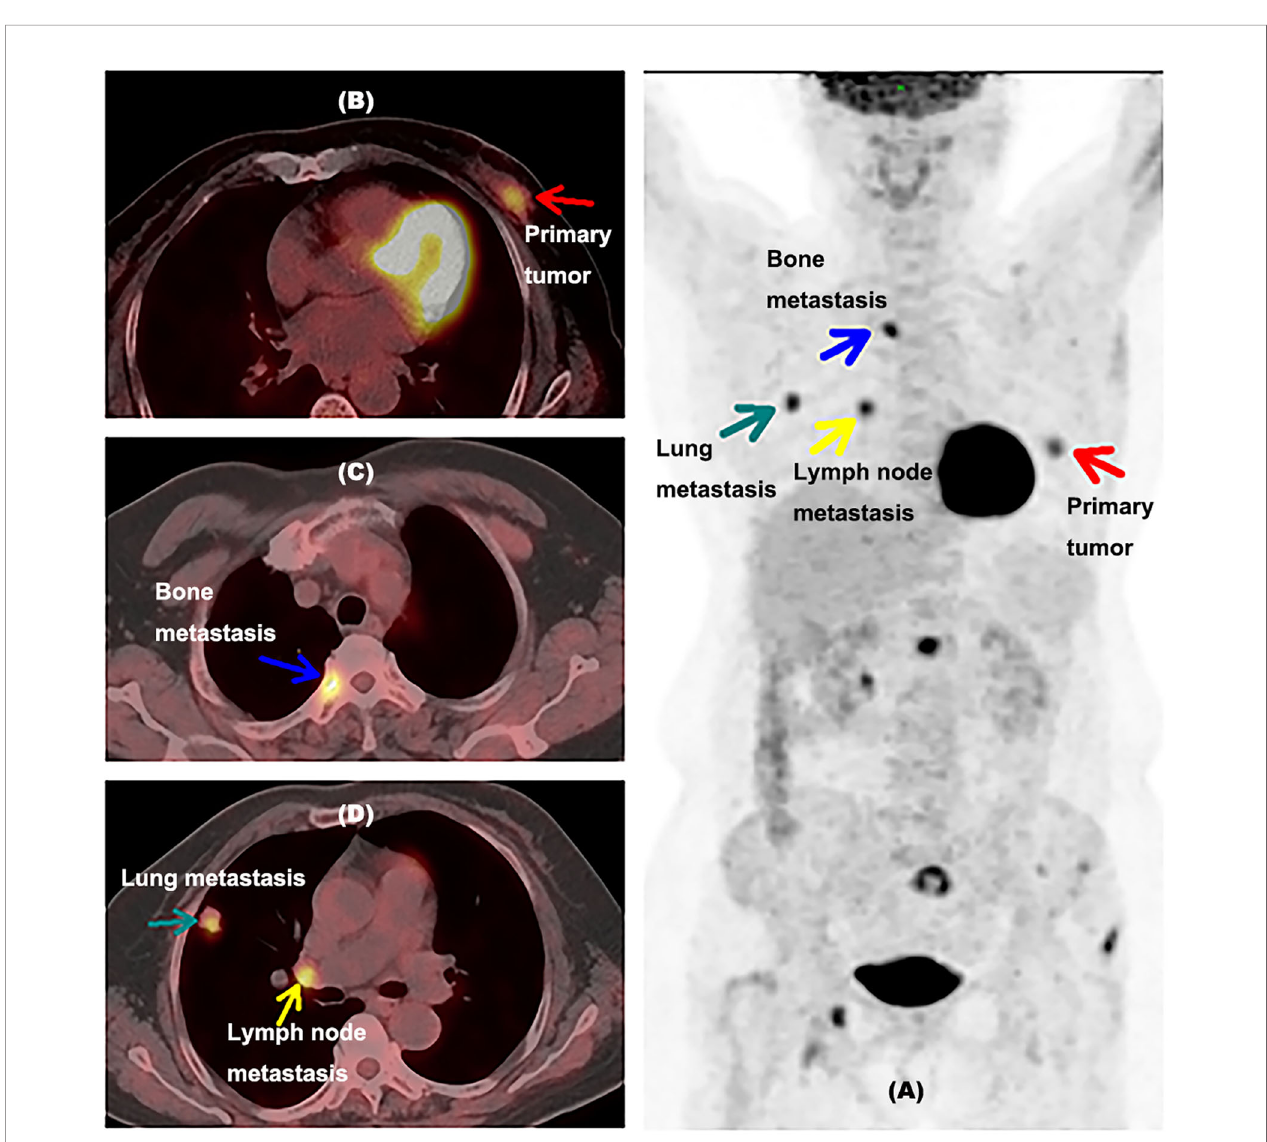
FIGURE 5 | Example for a newly diagnosed breast cancer patient with unsuspected lung, hilar lymph node, and bone metastases detected by 18F-FDG PET/CT inspection. (A) A MIP picture of a 63-year-old newly diagnosed breast cancer woman detected by an 18 F-FDG PET/CT inspection with the proportion of ER at 10%. The red arrow showed the primary tumor of this patient. The green arrow indicated lung metastasis in the right lung. The yellow arrow presented hilar lymph node metastasis. The blue arrow showed bone metastasis. (B) PET/CT fusion image of this woman with primary tumor. (C) PET/CT fusion image of this woman with lung metastasis and hilar lymph node metastasis. The green arrow indicated lung metastasis, and the yellow arrow presented hilar lymph node metastasis. (D) PET/CT fusion image of this woman with bone metastasis. ER, estrogen receptor; MIP, maximum intensity projection, with the proportion of ER lower than